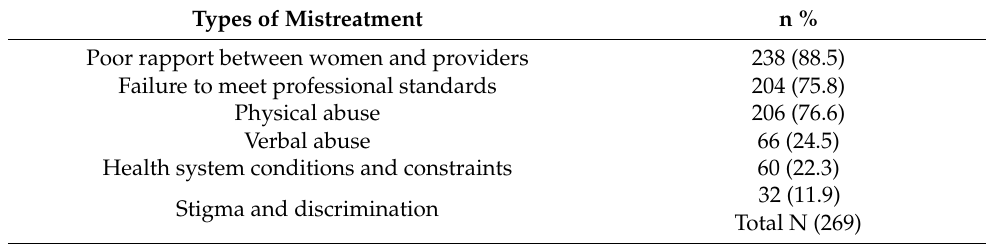
Table 4. Frequency of types of mistreatment experienced by the women during childbirth (n =